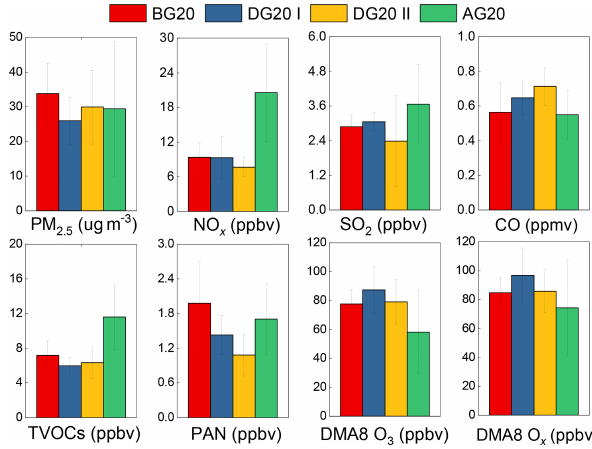
Figure 2. The comparisons of daytime PM 2 . 5 , NO x , SO 2 , CO, the total VOCs, PAN, DMA8 O 3 , and DMA8 O x . before, during, and after G20, denoted as BG20, DG20, and AG20, respectively. The error bars represent the standard